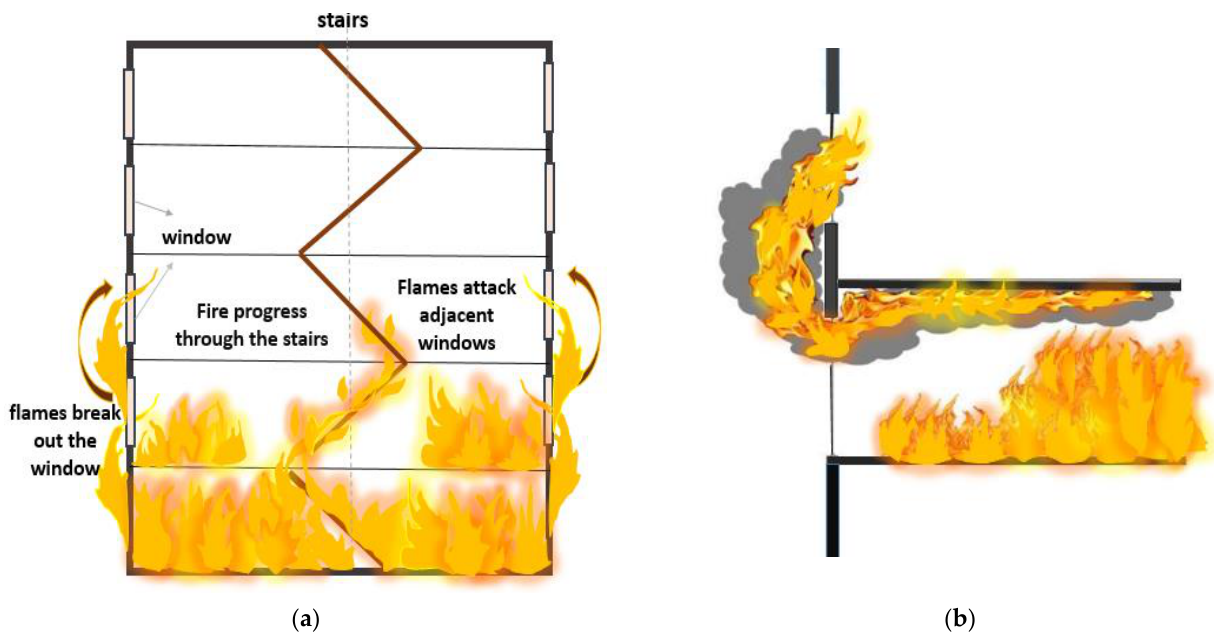
Figure 8. ( a ) Mechanism of fire spread in a building by the external windows and stairs, ( b ) The Coanda effect.